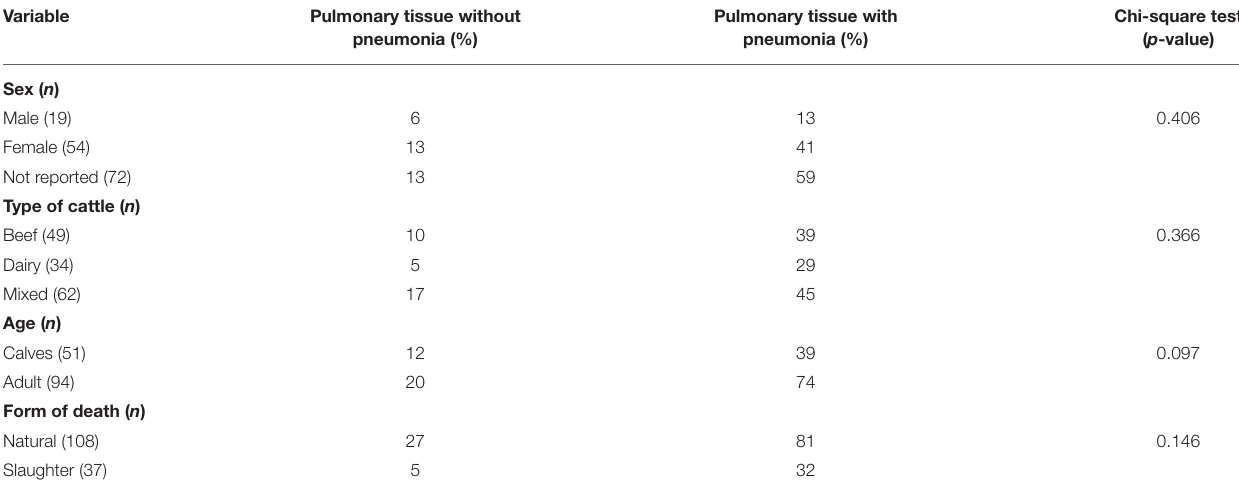
TABLE 1 | Epidemiological data of pulmonary tissue of cattle submitted for histopathologic diagnosis.